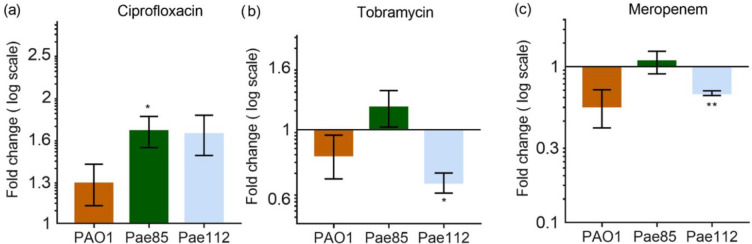
Pyocyanin quantification when strains exposed to sub-MIC antibiotic concentrations.Changes in pyocyanin levels in response to treatment of 10x sub-MIC of (a) ciprofloxacin (Cipro), (b) tobramycin (Tobra), and (c) meropenem (Mero), tested on PA01, Pae85, and Pae112. The changes in pyocyanin production are normalized using optical density (OD600 nm). Data from single strain analysis with means ± SEM from 3 to 4 replicates (Paired t-test, *P<0.0332, **P<0.0021).